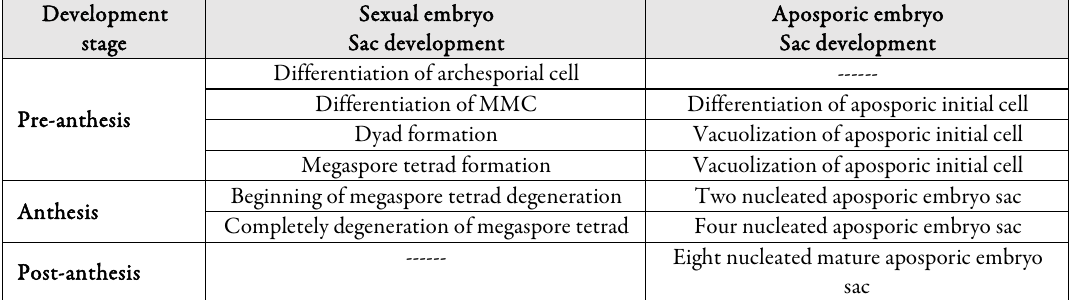
Table 1. The comparison of sexual and aposporic embryo sac development with different flower developmental stages in C. tanacetifolia